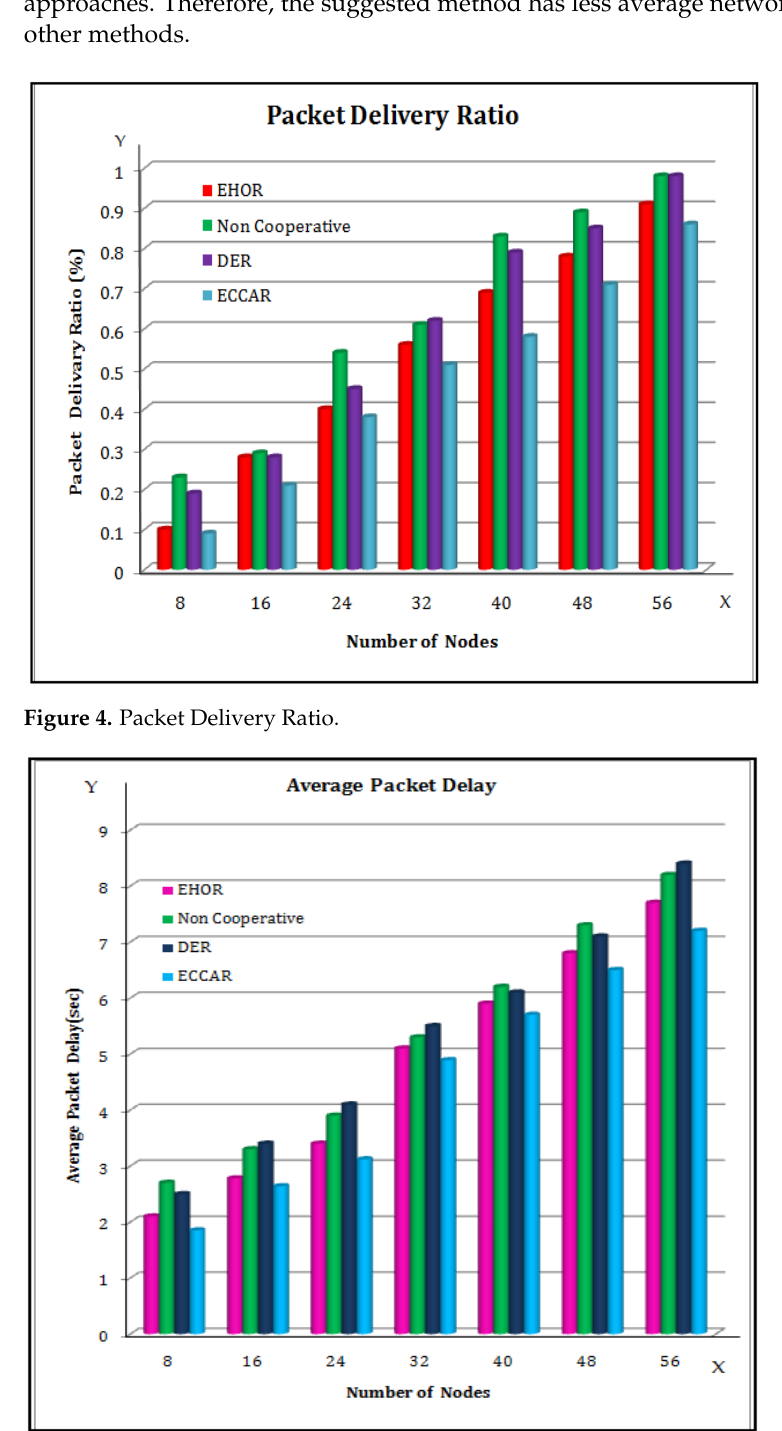
Figure 5. Average packet